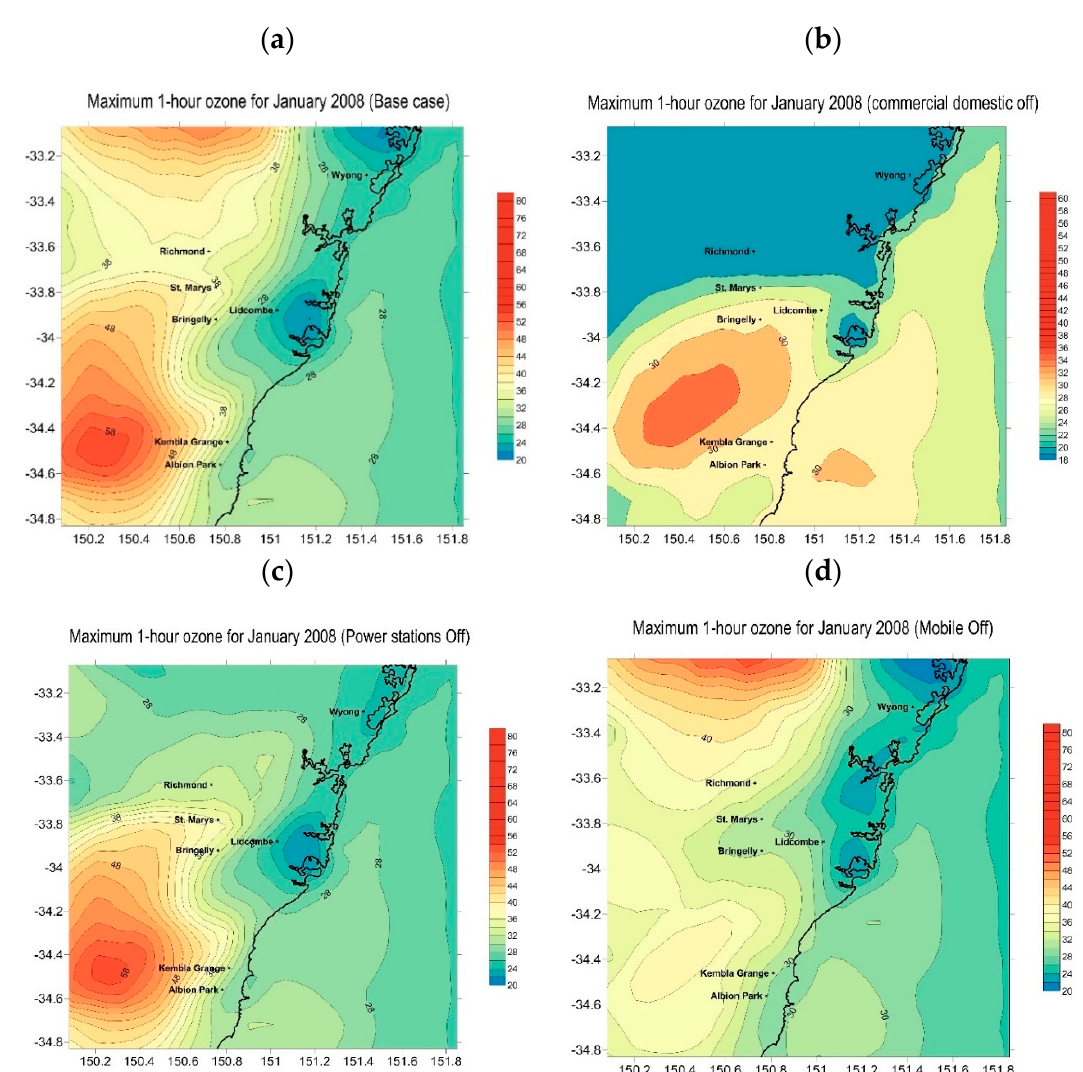
Figure 7. Monthly average of daily maximum 1-hour ozone concentration for January 2008 in ( a) base case, ( b ) commercial-domestic sources off, ( c ) power stations sources off and ( d ) on-road mobile sources off emission scenarios.